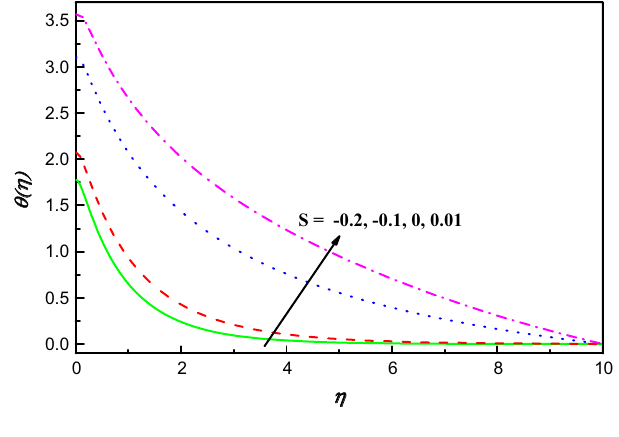
Figure 6. θ(η) variation vs. S .